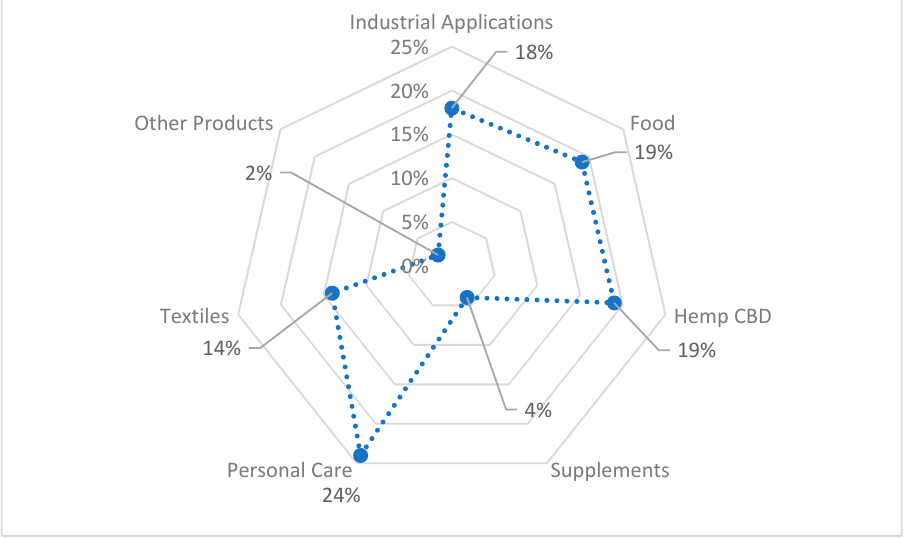
Figure 3. Hemp-based product sales by category, 2015, based on [13].